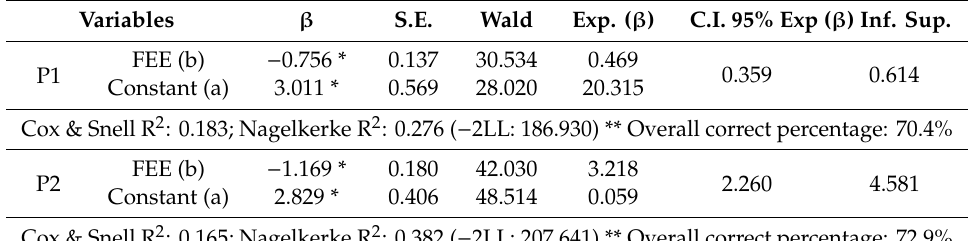
Table 17. Logistic regression results for WTPEF in the MTNP